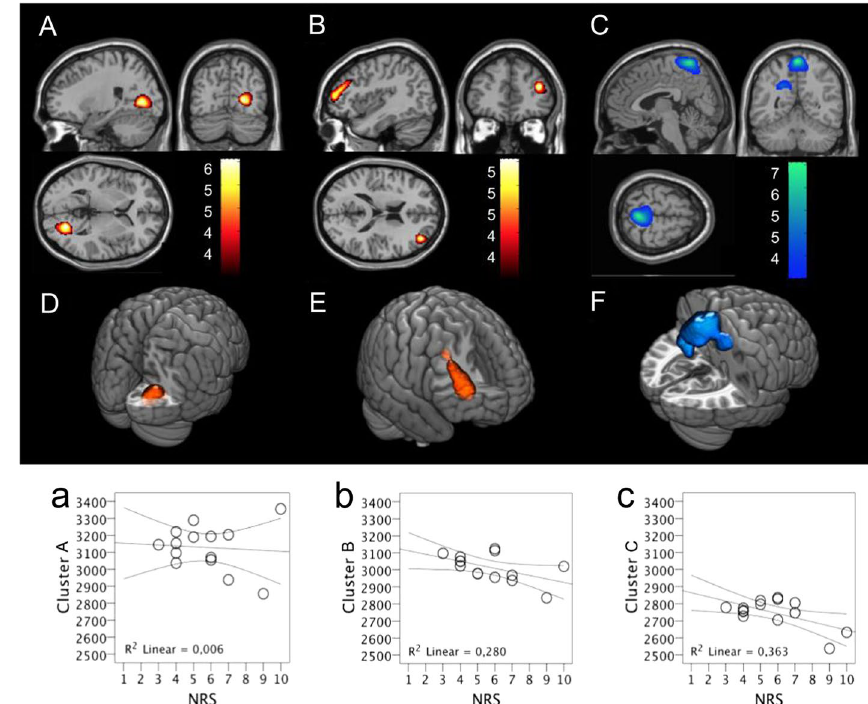
Fig. 2 Results of the statistical parametric mapping (SPM) analysis showing brain regions with significant rCBF changes in 14 patients with CLBP, compared to ten healthy controls. The figure shows the overlay of clusters upon T1‑weighted magnetic resonance imaging from the SPM template. Images show areas with a significant increase ( A , B , D , and E ) and decrease ( C and F ) of the regional cerebral blood flow (rCBF). The significant increase of rCBF was found in clusters A (3D view in D ; R occipital lobe and R posterior cingulate gyrus) and B (3D view in E ; R anterior prefrontal and dorsolateral frontal lobe). Cluster C presented a decrease of rCBF (3D view in F ; bilateral parasagittal and postcentral parietal lobe and R middle cingulate cortex). Table 2 describes the Talairach coordinates. Results are shown in p value less than 0.05, corrected for multiple comparisons. A correlation coefficient with 95% CI according to Kendall’s tau non‑parametric rank correlation was used to assess the relationship between the rCBF increase ( a , b , d , and e ) and decrease ( c and f ) and the results of the NRS ( a – c ) and DN4 ( d – f ) scores. The curved lines show the 95% CI around the regression line. In b , higher NRS scores were inversely and moderately correlated with the intensity of rCBF increase in cluster B (Kendall’s tau 0.445, p 0.033). In a , c , d , e , and f , there was no significant correlation between rCBF = − = changes and NRS or DN4 scores. NRS Numeric Rating Scale; DN4 Douleur Neuropathique en 4